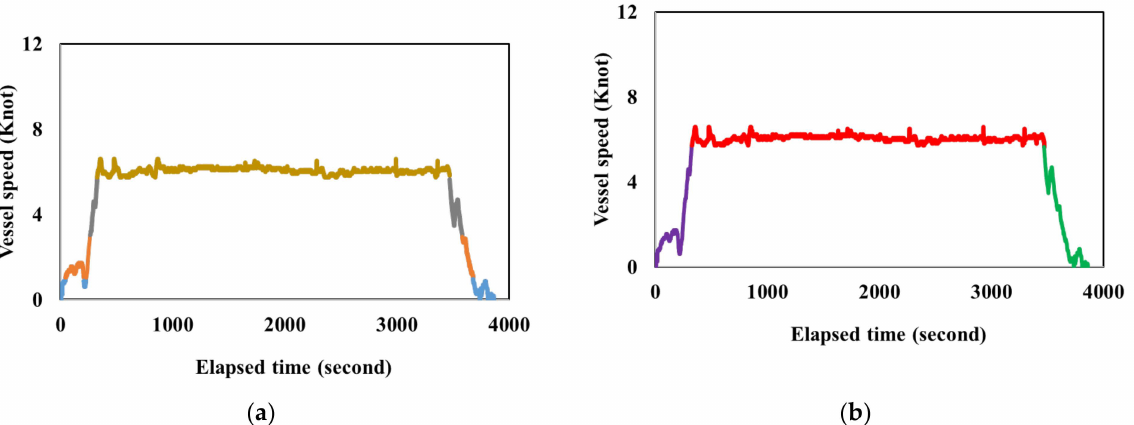
Figure 1. Operating modes of tested ship No. 1 based on two classification methods. ( a ) The operating modes classified by activity model, which are “at berth” (Blue), “at anchorage” (Orange), “maneuvering” (Gray), and “at sea” (Gold).; ( b ) The operating modes classified by recent inland ship emission studies, which are “Port departure” (Purple), “Cruise” (Red), and “Port arrival”